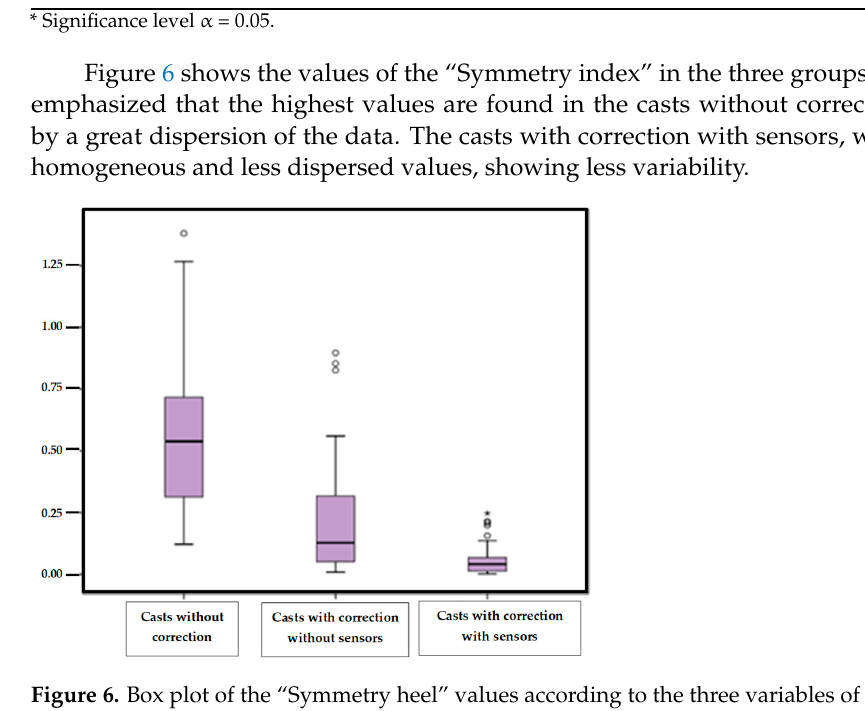
Figure 6. Box plot of the “Symmetry heel” values according to the three variables of the study.